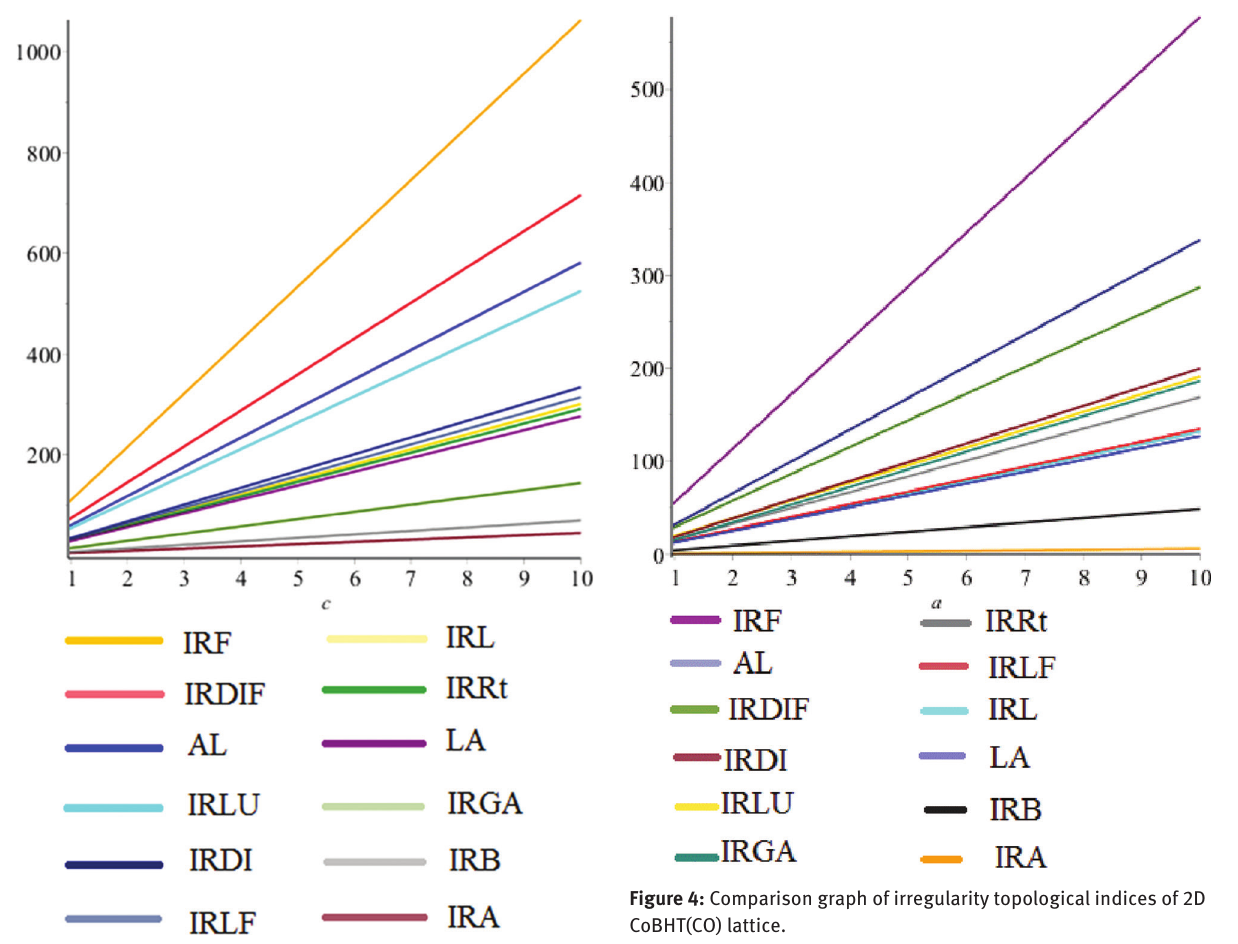
Figure 3: Comparison graph of irregularity topological indices of 2D structure of M1TPyP-M2 metal organic